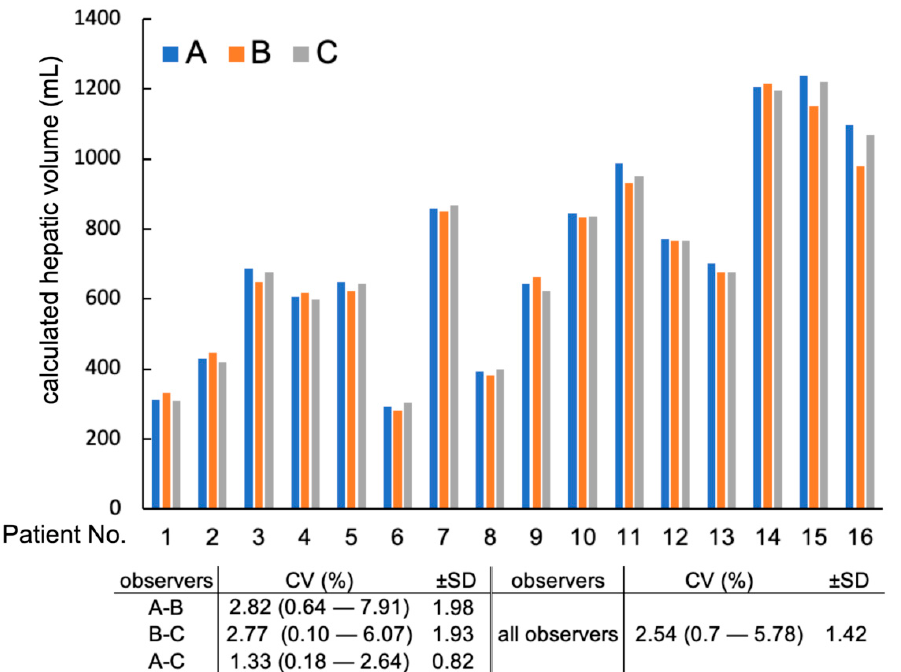
Figure 2. Interobserver variability of calculated full hepatic volumes by each observer. CV: Coefficient of Variation. Patients from 1 to 8 were with 2.5 mm slice intervals, whereas patients 9 to 16 were with 3.75 mm slice intervals.